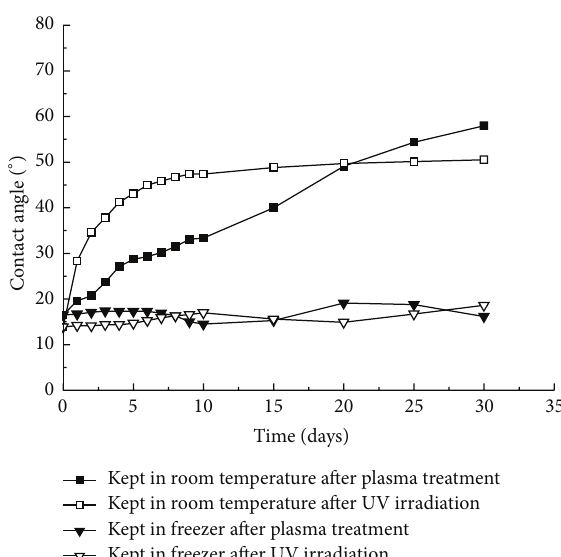
Figure 5: Contact angle ageing curve of PLGA films after treatment.